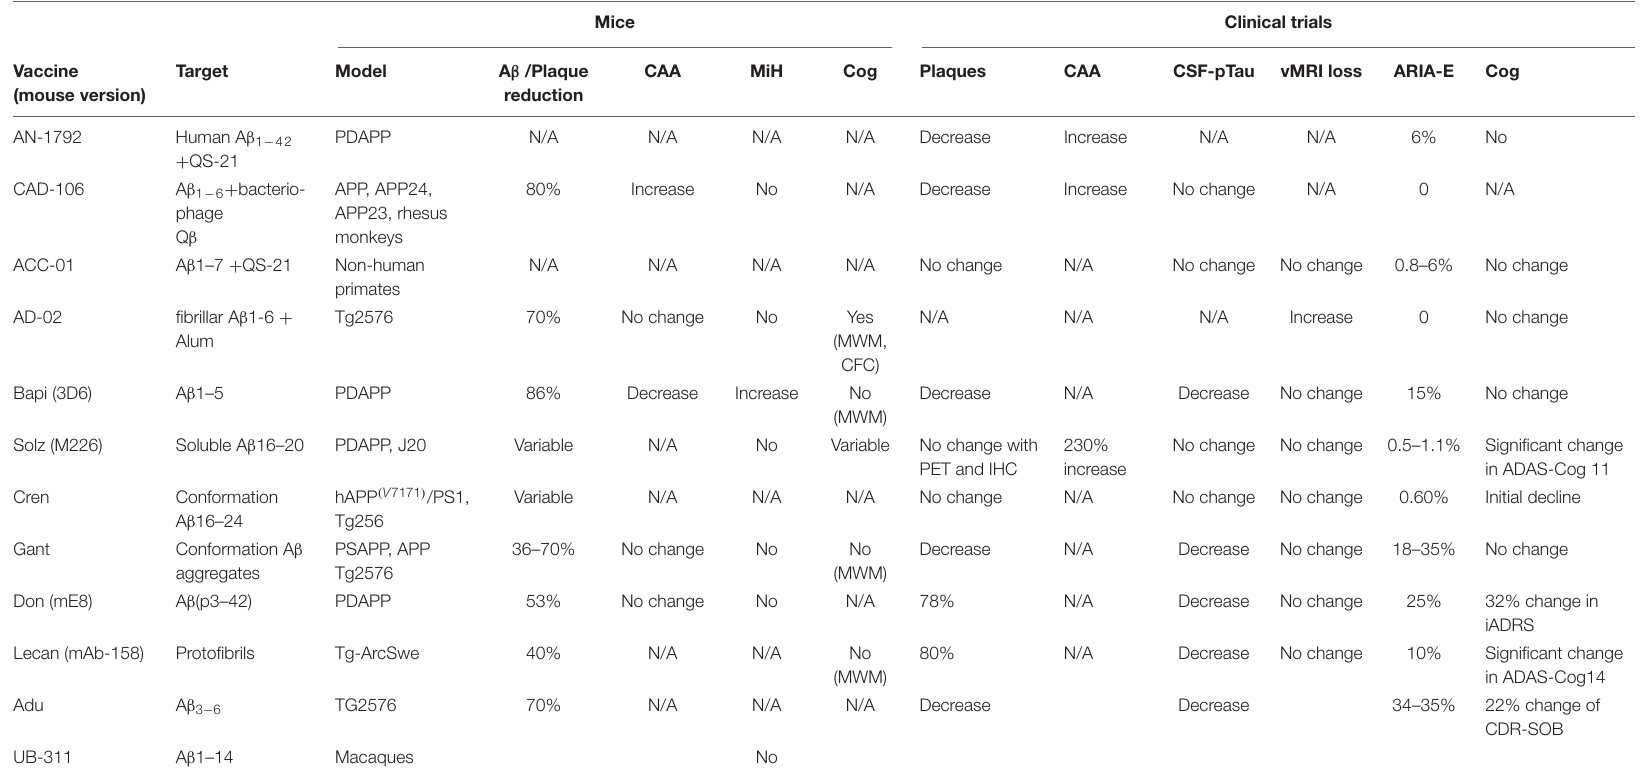
TABLE 5 | Comparison between A β immunotherapy in animal models and human clinical trials. Mice Clinical